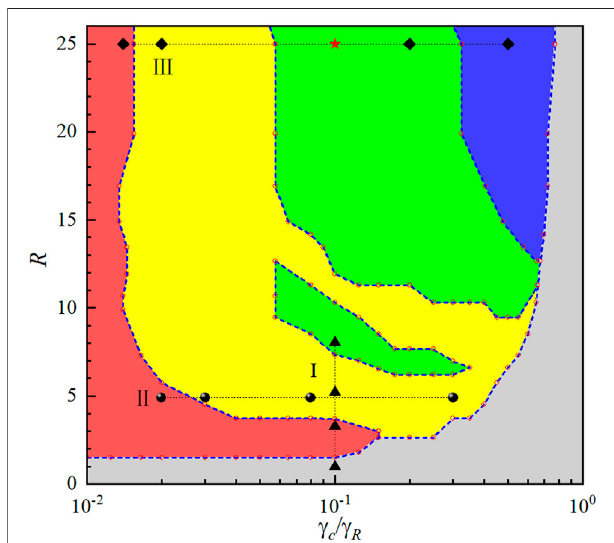
FIGURE 1 | (Color online) Phase diagram described by Eq. 1 for the pumping radius R and the decay ratio c c / c R . Different colors represent different types of steady states of polaritons: approximate Gaussian distribution (red), vortices (yellow), solitons (green), ring mode (blue), and unstable region (gray). The blue dotted lines show approximate phase boundaries.